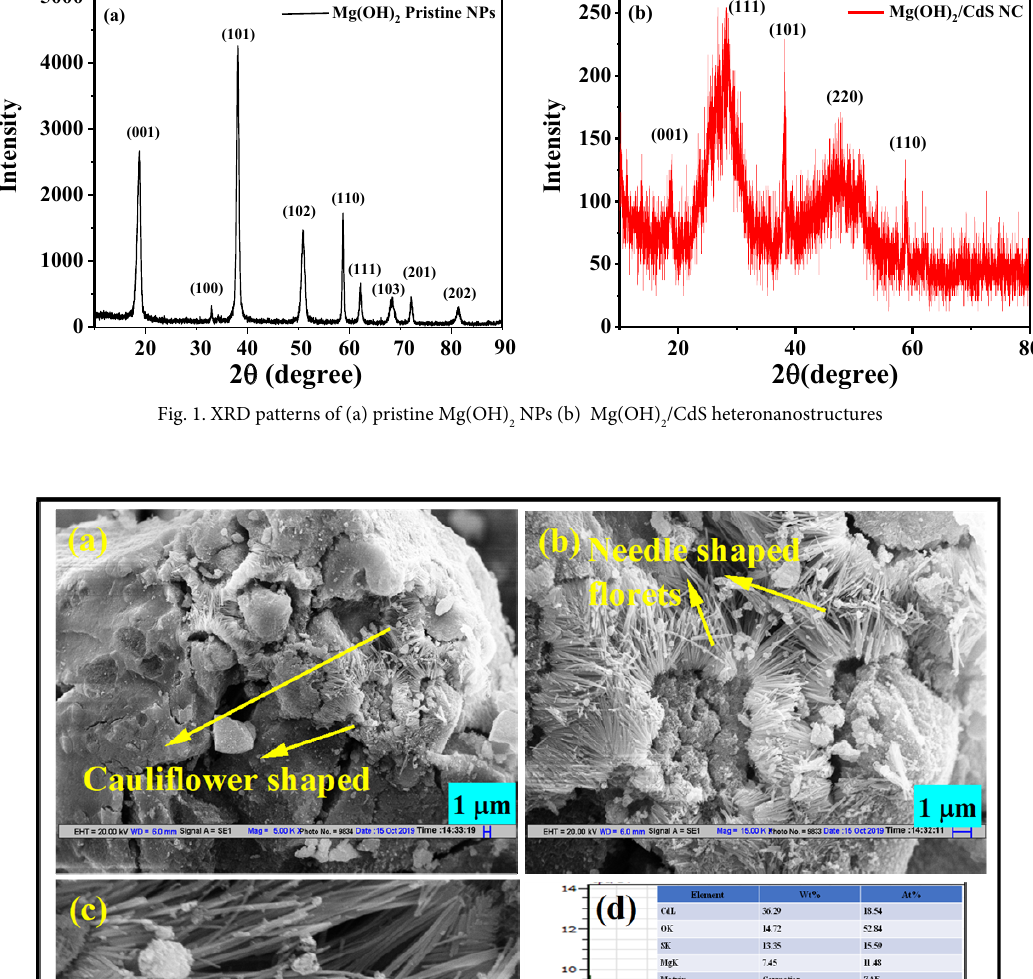
/CdS hetero nanostructures and (d) showing energy dispersive X-ray 2 analysis of Mg(OH) /CdS hetero 2